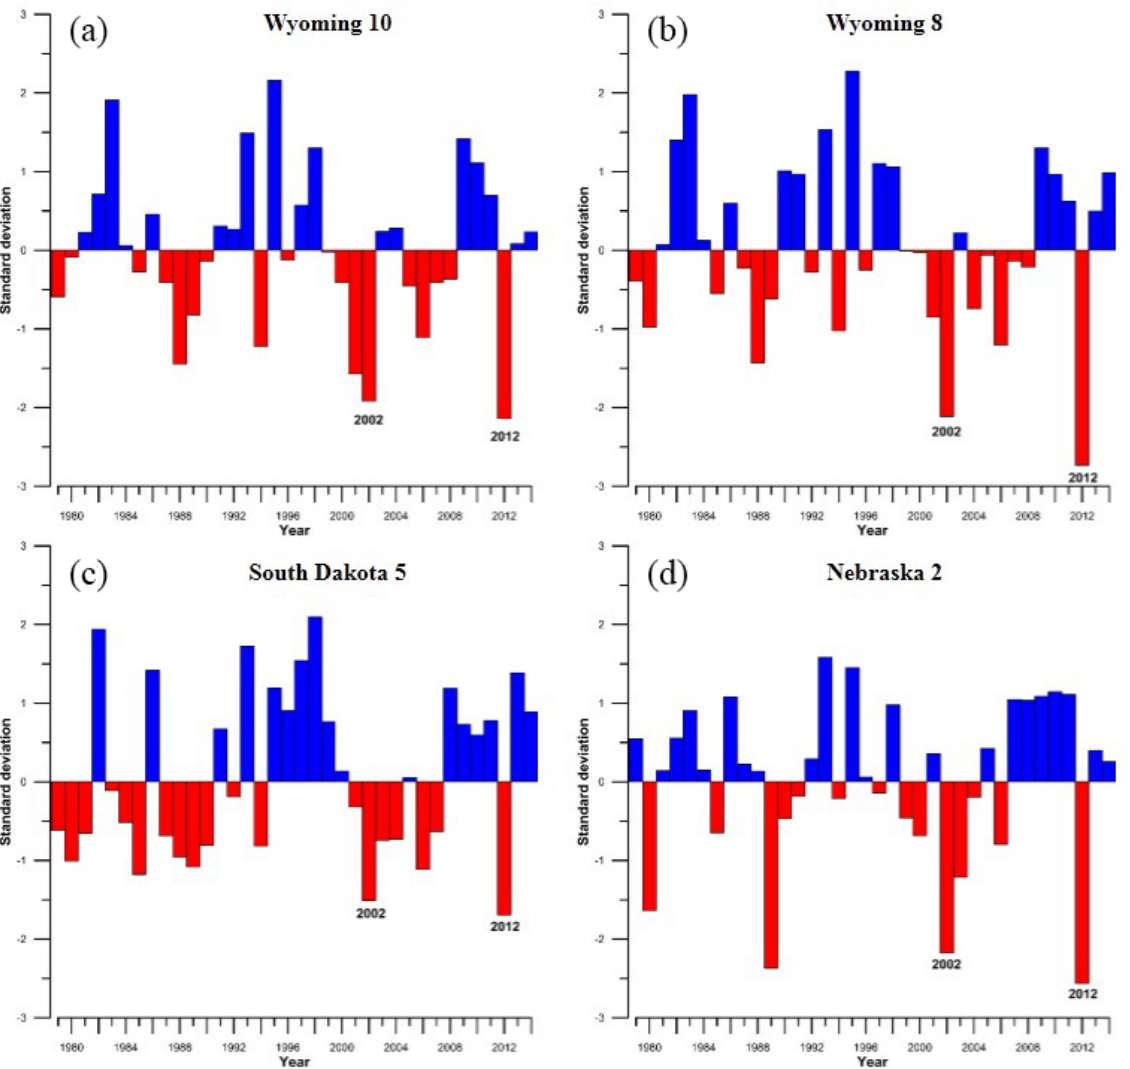
Figure 3. Time series of precipitation anomalies from Wyoming Climate Divisions 10 (a) and 8 (b) , South Dakota Climate Division 5 (c) , and Nebraska Climate Division 2 (d) . Annual precipitation anomalies for 1979–2014 were compared to the long-term average (1981–2010) from each climate division. Case years that were greater than − 1 standard deviations below the long-term average, or in the 10th percentile, were chosen as modern analogues to investigate dry conditions during the 4.2ka megadrought in the central Rocky Mountains (Carter et al., 2017a), and western Great Plains (Stokes and Gaylord, 1993; Halfen et al., 2010; Rawling et al., 2003; Schmieder et al., 2011; Miao et al., 2007; Mason et al., 2004; Goble et al., 2004; Stokes and Swinehart, 1997; Loope et al., 1995; Ahlbrandt et al., 1983; Madole, 1995). Climate division data were collected from https://www.esrl.noaa.gov/psd/data/timeseries/ (last access: 26 June